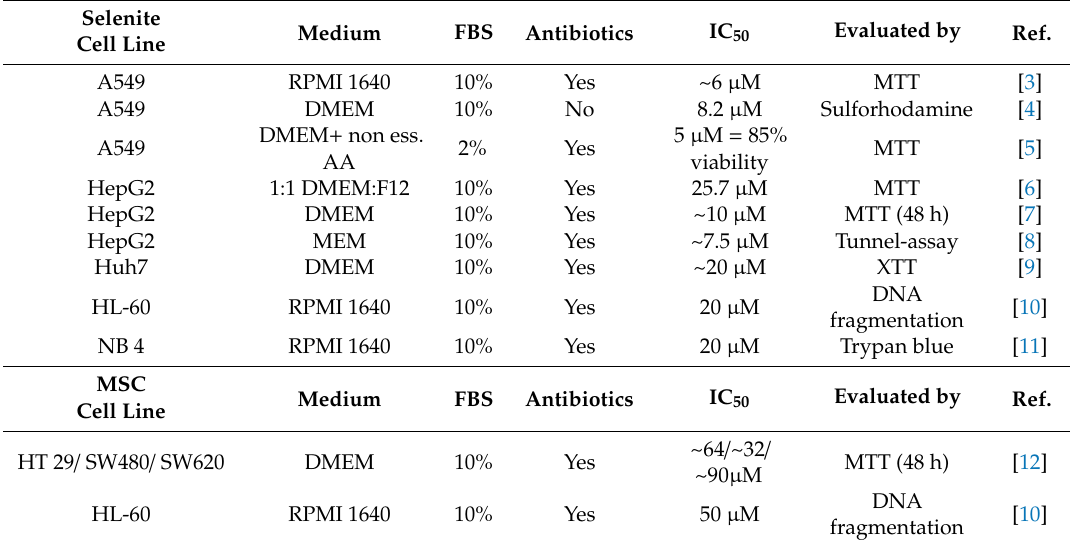
Table 1. Varying IC 50 values after 24 h of treatment with selenite or seleno-methylselenocysteine (MSC) shown in di ff erent studies.